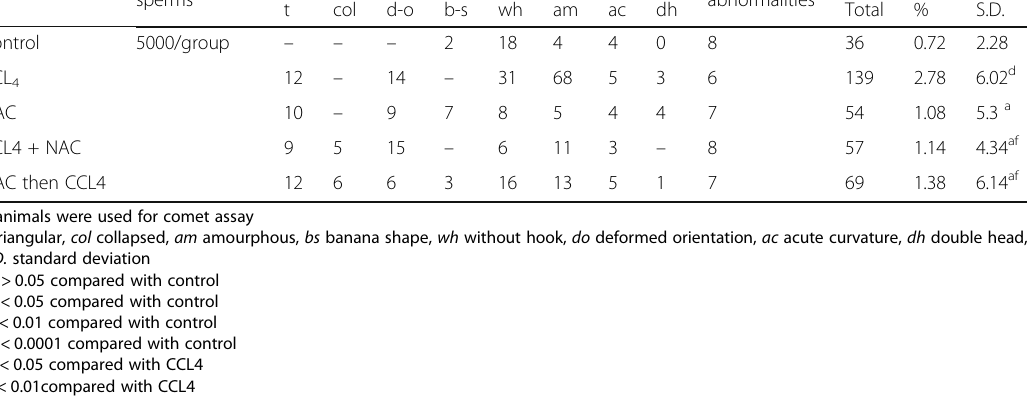
Table 2 Percentages of abnormal sperms and tail moments in rats post-treatment with CCL 4 and/or NAC Treatment